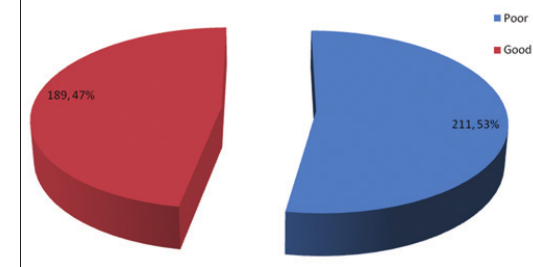
Figure 2 . Attitudes Towards Birth Preparedness and Complica- tion Readiness among Respondents.